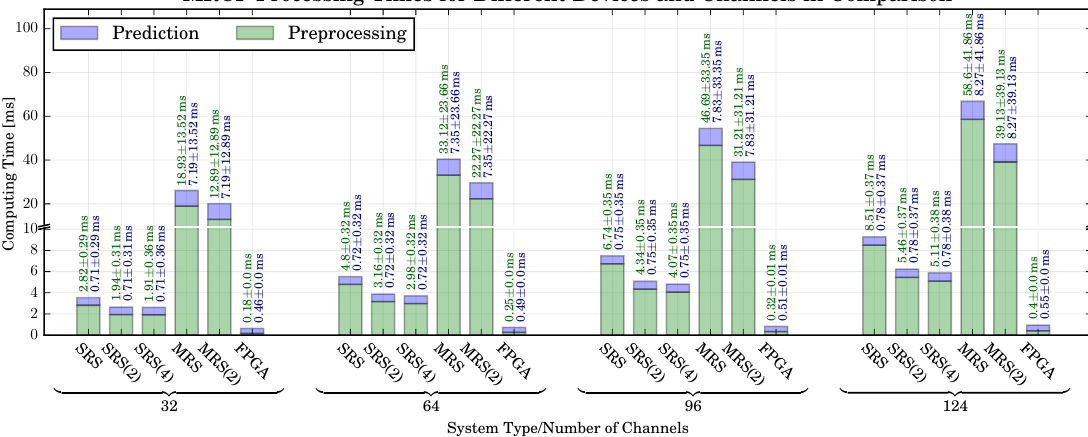
Figure 9. Computing times of different computing setups for 32–124 channels for the detection of the Movement Related Cortical Potential (MRCP). For the Standard-PC Reference System (SRS) system, the number of threads are put in